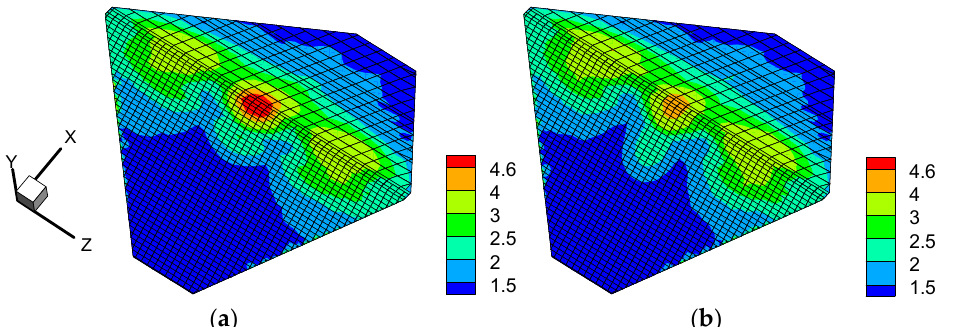
Figure 21. Maximum distribution of rockfill acceleration along the upstream–downstream direction (m/s 2 ): ( a ) Neglecting hydrodynamic pressure and ( b ) the Polyhedron SBFEM.